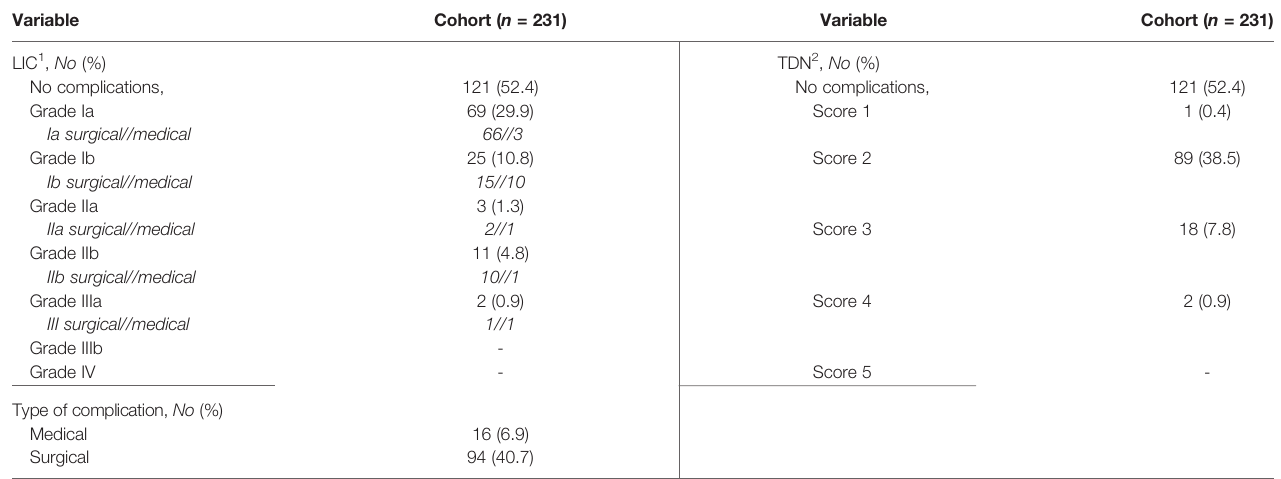
TABLE 2 | Comparison between LIC grade and TDN score ( N = 231).